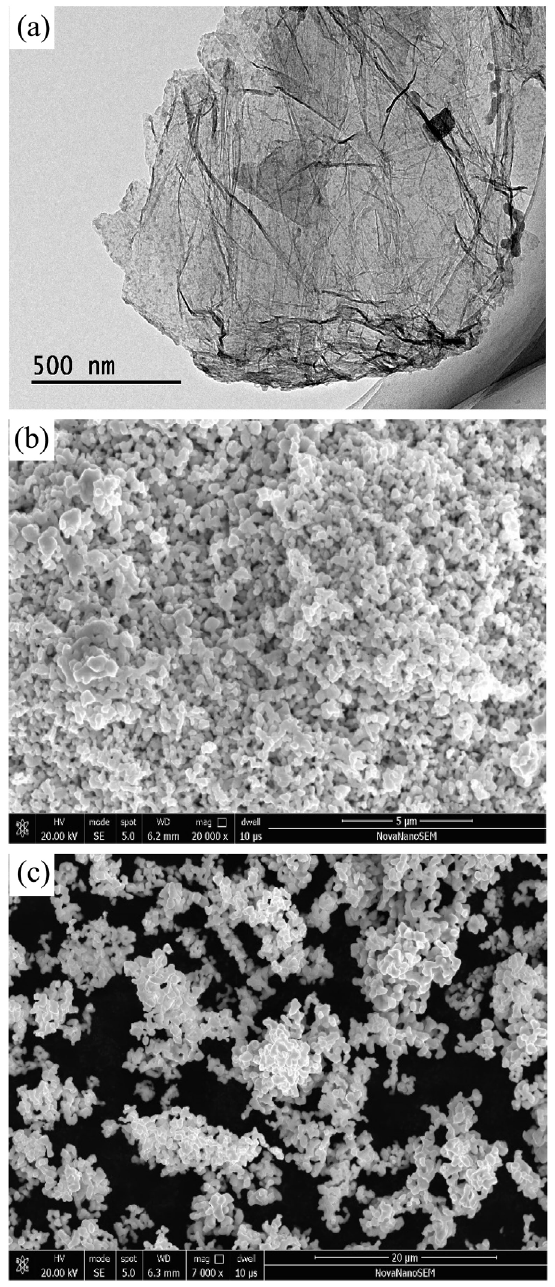
Fig. 1 SEM images of the raw materials: (a) graphene, (b) WC, and (c) Co. Table 1 Physical properties of the graphene used for testing. Surface area Density (>m 2 (g/cm 3 )